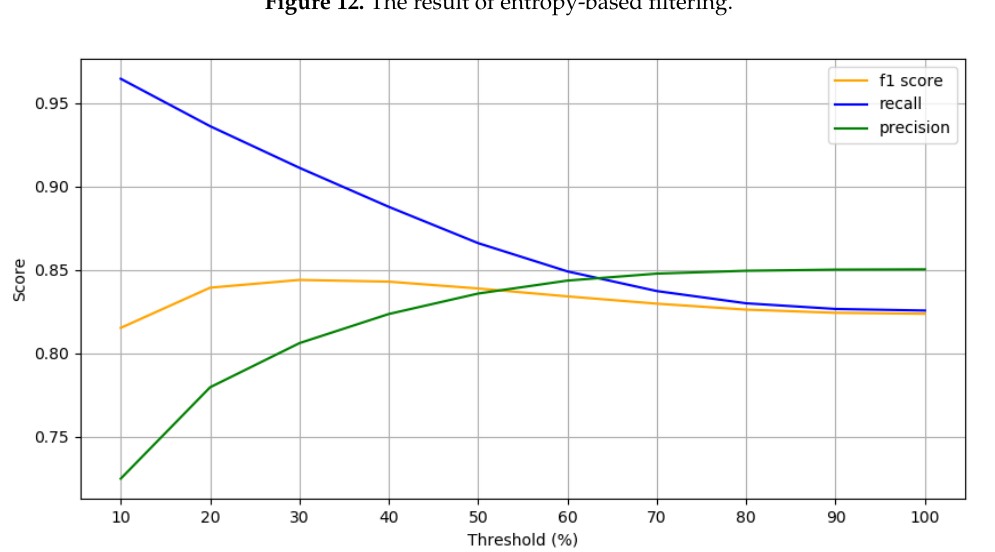
Figure 12. The result of entropy-based filtering.